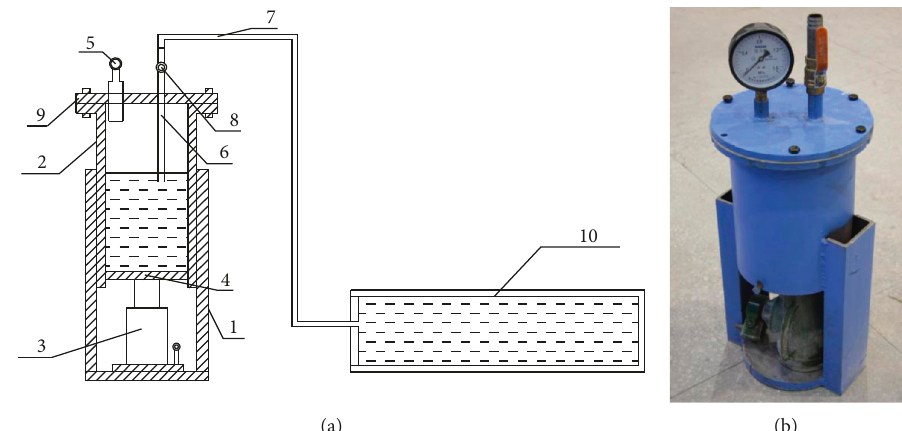
Figure 4: Dynamic paste filling device.1, base; 2, inner cylinder; 3, jack; 4, loading plate; 5, pressure gage; 6, pumping port; 7, high-pressure hose; 8, flowmeter; 9, top cover; 10, filling groove.